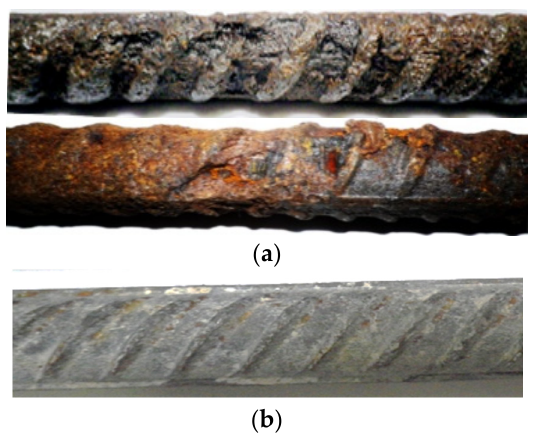
Figure 1. Corrosion of the steel reinforcement [22–23]. ( a ) Corrosion period of 26 years. ( b ) Non-corroded steel reinforcement.